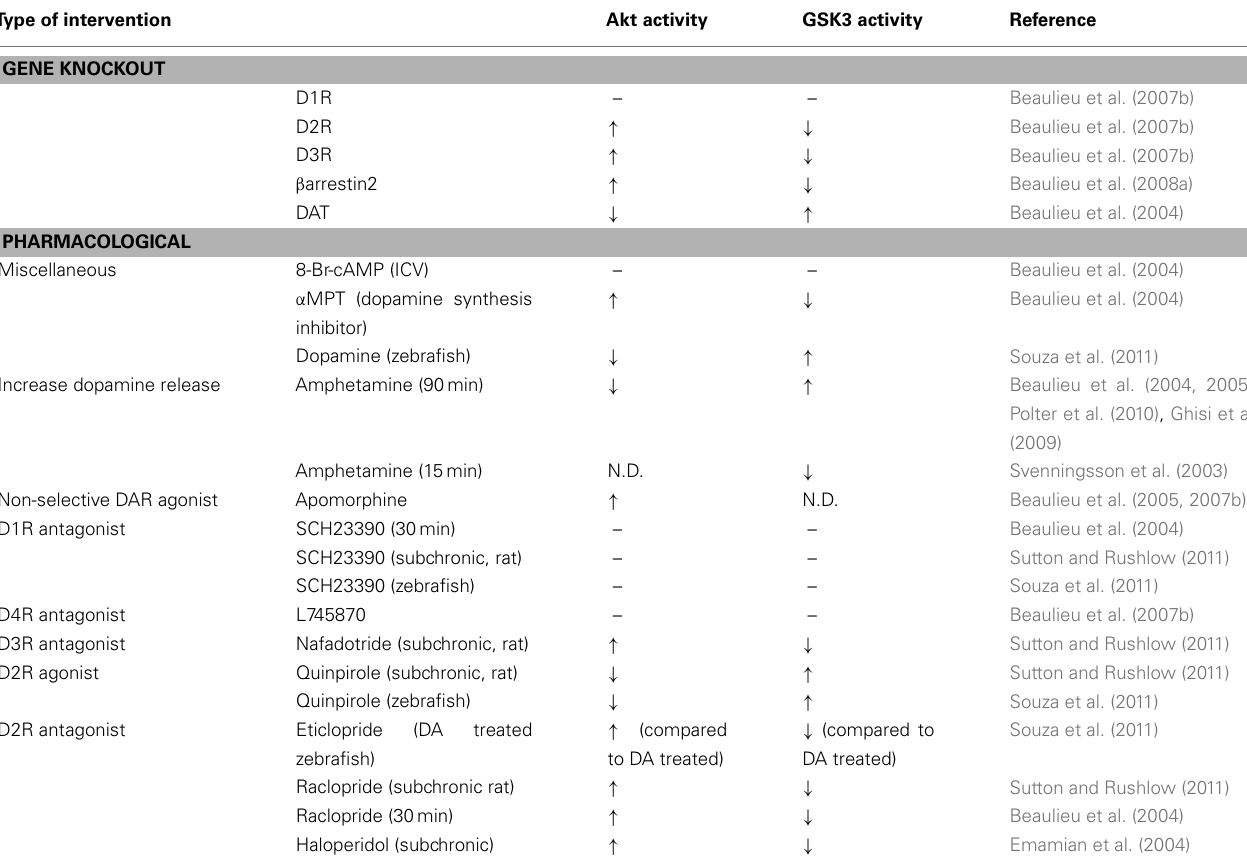
Table 1 | Effect of pharmacological and genetic manipulation of dopamine receptor activation onAkt and GSK3 activity in vivo